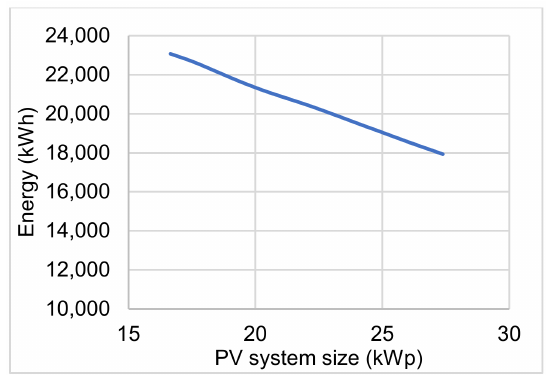
Figure 12. Mismatch losses.